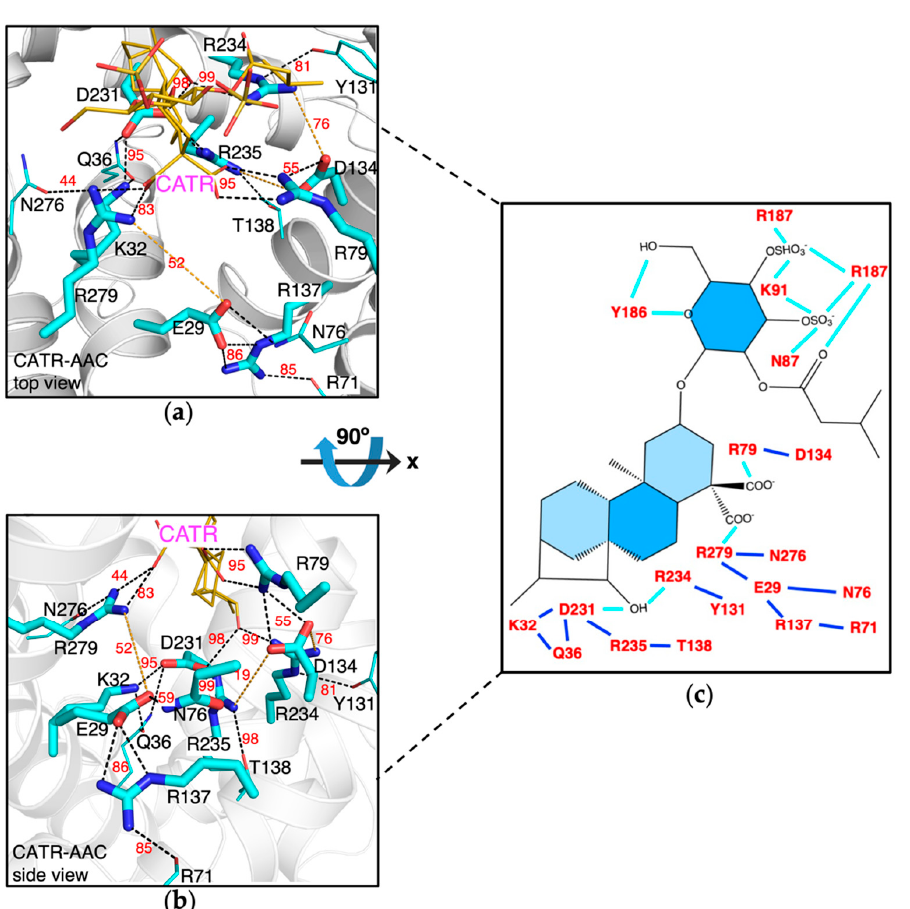
Figure 3. The m-gate electrostatic network in the AAC-CATR complex. Top view ( a ) and side view ( b ) of the AAC-CATR interactions in the last simulation snapshot (1 µ s). CATR is shown in yellow think sticks. In the side-view figure, protein backbones are shown in transparent cartoon. Yellow dash lines are added manually to indicate the H-bonds that do not appear in the shown snapshot. Q36 forms H-bond with both D231 (occupancy: 71%) and K32 (occupancy: 94%), and these values are not labeled in the figure because of limited space. The H-bonds with the occupancies lower than 5% are not shown. The occupancies are calculated on the trajectory from 200 ns to 1 μ s. ( c ) A schematic representation of the CATR-AAC interactions. The electrostatic interactions between CATR and AAC are shown in cyan lines, and the interactions within the m-gate network are shown in blue lines.